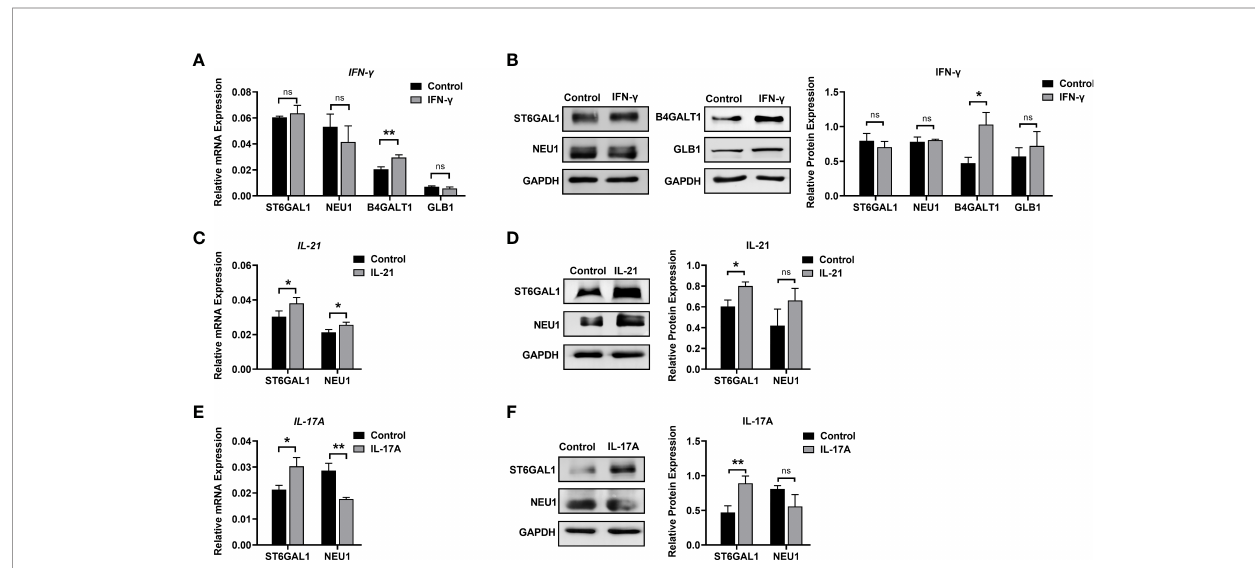
FIGURE 6 | Changes in glycosylation enzymes in B cells under stimulation. (A) mRNA expression of B4GALT1, GLB1, ST6GAL1, and NEU1 under stimulation with IFN- g . (B) Protein expression of B4GALT1, GLB1, ST6GAL1, and NEU1 under stimulation by IFN- g . (C, E) mRNA expression of ST6GAL1 and NEU1 under stimulation by IL-21 and IL-17A, respectively. (D, F) Protein expression of ST6GAL1 and NEU1 under stimulation by IL-21 and IL-17A, respectively. Total RNA was extracted from activated B cells after 12 h of stimulation. Protein was also collected from activated B cells after 72 h of stimulation. The mRNA and protein expression of glycosylation enzymes was normalized to the GAPDH mRNA and GAPDH protein relative staining intensity. The error bars represent the SD. ns means no signi fi cance, * p < 0.05, ** p <